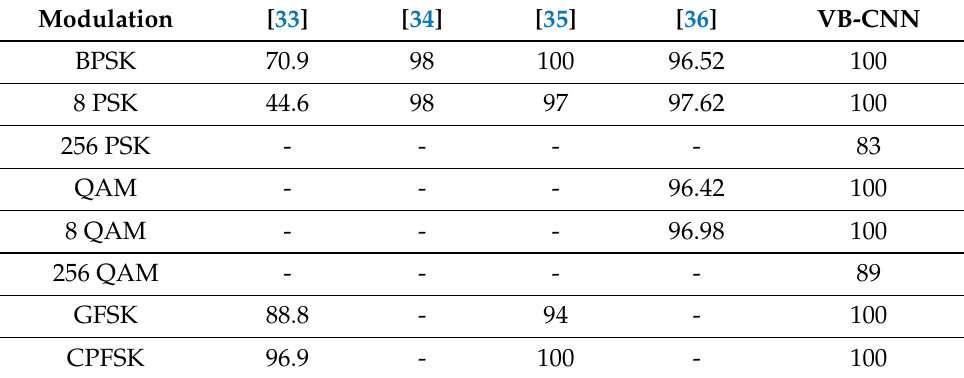
Table 4. Comparison of Proposed VB-DCNN Classifier with State-of-the-Art Existing Techniques.